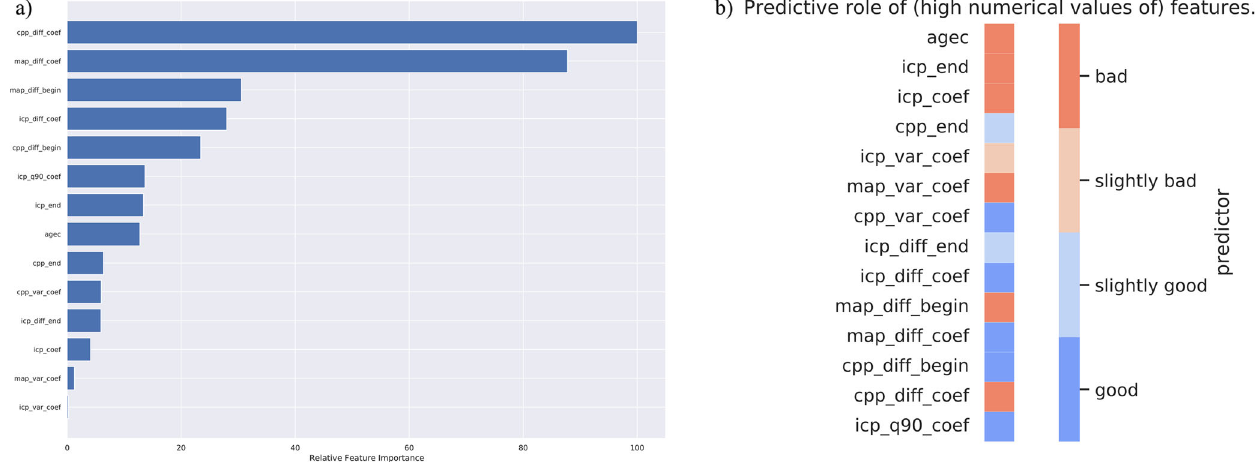
Fig. 3 Relative feature importance and the direction of the predictions. The relative feature importance in descending order: cpp_diff_coef, map_diff_coef, map_diff_begin, icp_diff_coef, cpp_diff_begin, icp_q90_coef, icp_end, agec, cpp_end, cpp_var_coef, icp_diff_end, icp_coef, map_var_coef, icp_var_coef ( a ). Heat map showing the predictive role of included features ( b ). Red indicates that a higher feature value increases probability of death and blue indicates that a higher feature value increases probability survival. begin = mean value from the fi rst derived 24-hour time-window; end = mean value from the last derived 8 h; coef = slope of the linear coef fi cient from the start of the derived time-window up to the time of the prediction; q90 = 90th percentile in the derived time-window; diff = mean of differences between consequent values in the derived time-window, var variance in the derived time-window, icp intracranial pressure, cpp cerebral perfusion pressure, map mean arterial pressure, agec age